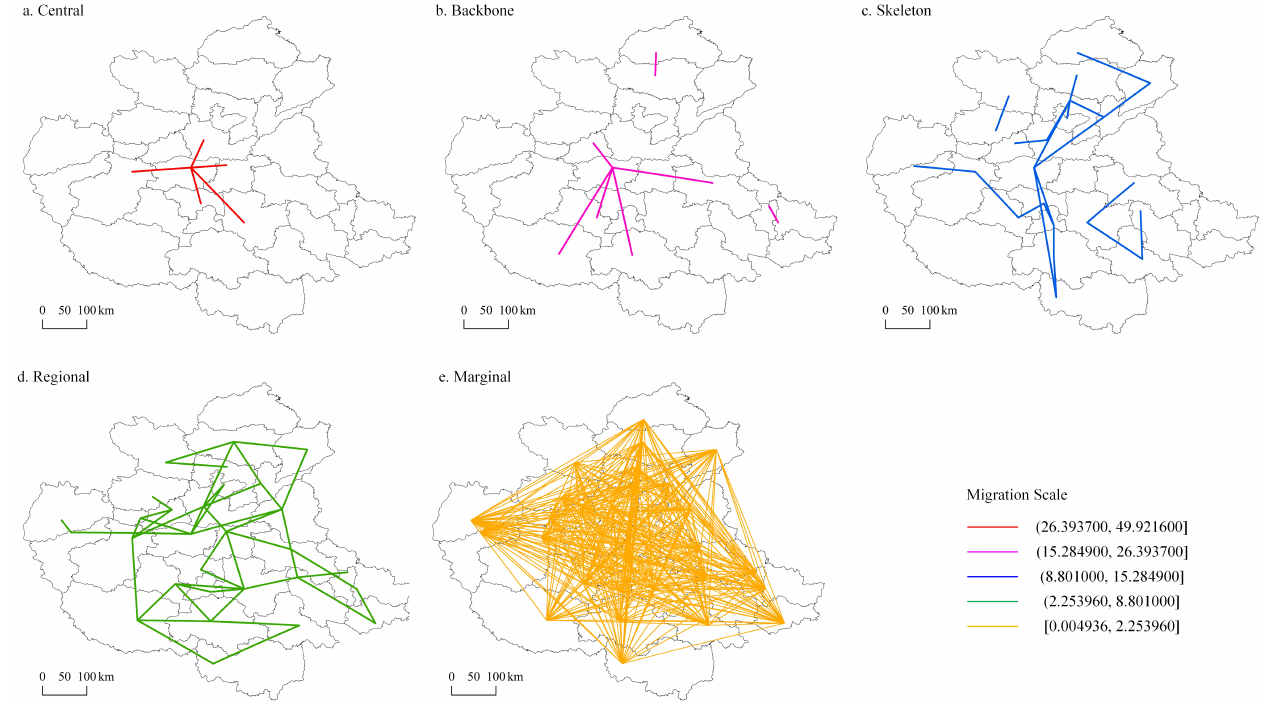
Figure 5. Migration network levels of Zhongyuan Urban